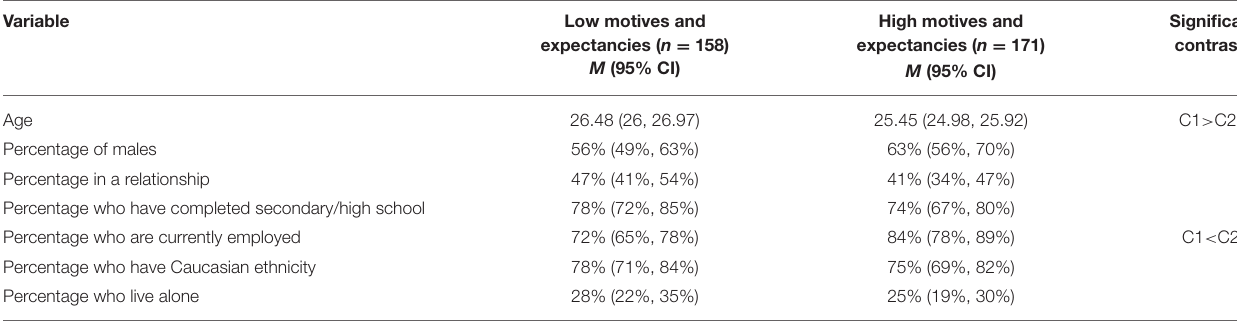
TABLE 3 | Means and confidence intervals of demographic outcome variables (2-class model) a .